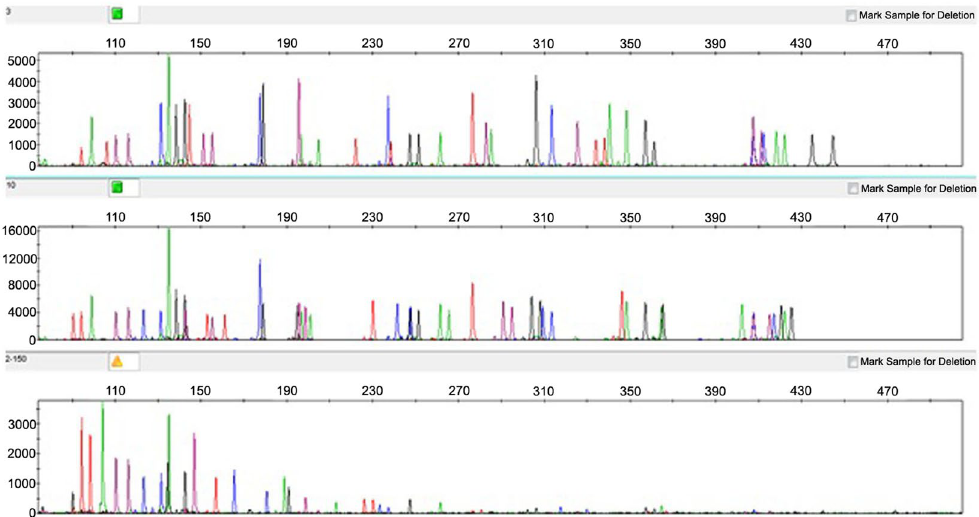
Figure 4. SureID PanGlobal electropherograms obtained from two different moderately degraded DNA bone samples (upper & medium panels) and from a severely degraded FFPEB sample (lower